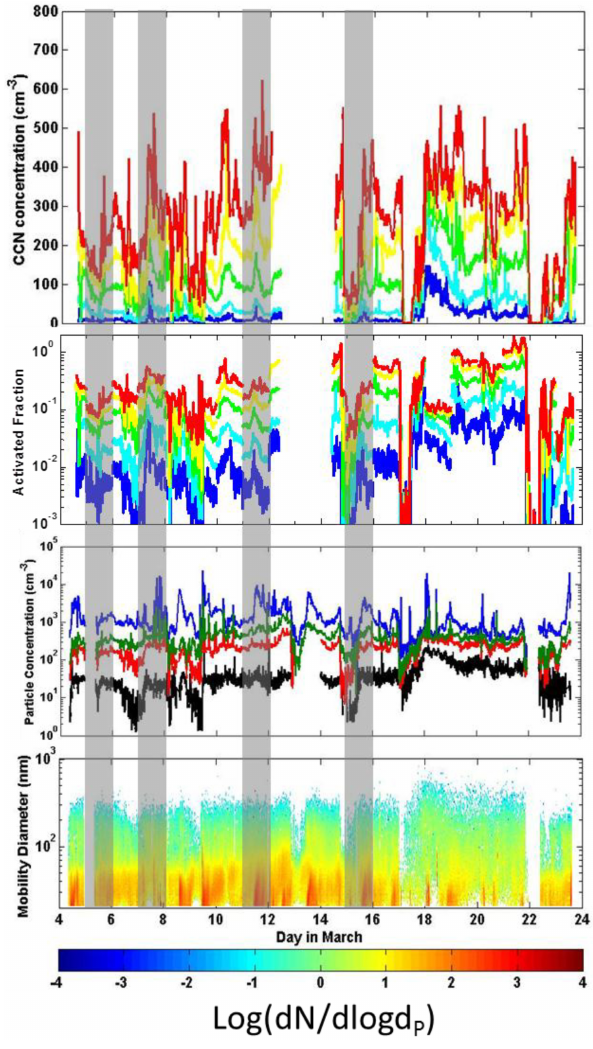
Fig. 2. Aerosol properties measured during March 2011 at Storm Peak Laboratory (SPL). (a) CCN concentrations as a function of supersaturation in the CCNC. Colors correspond to CCNC super- saturations: 0.07% (blue); 0.12% (cyan); 0.22% (green); 0.42% (yellow); 0.72% (red). (b) Activated fraction of CCN; colors are the same as (a) . (c) Total particle concentrations as a function of aerosol size (blue: all particles >20nm; green: particles >50nm; red: particles >80nm; black: particles >200nm). (d) Number size distributions (colorbar is dN / d logD p ). Grey shaded regions indi- cate days of detailed analysis